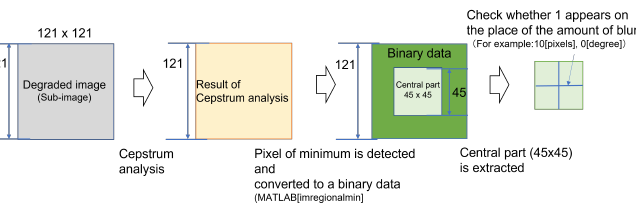
Figure 4. Procedure for confirming whether the blur amount can be estimated by cepstrum analysis.